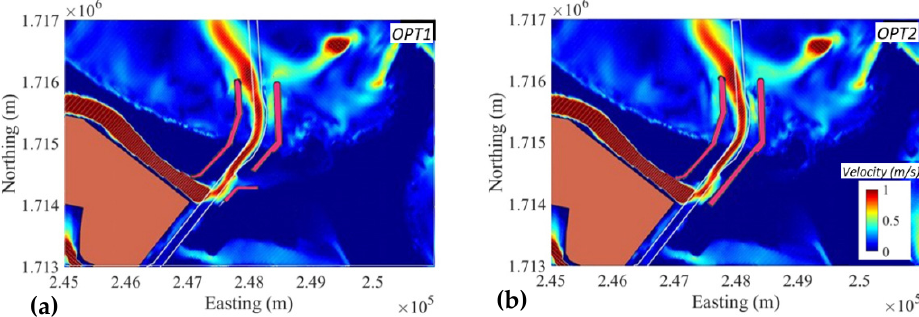
Figure 22. Current field during the flood with the frequency of 5% after jetty construction.